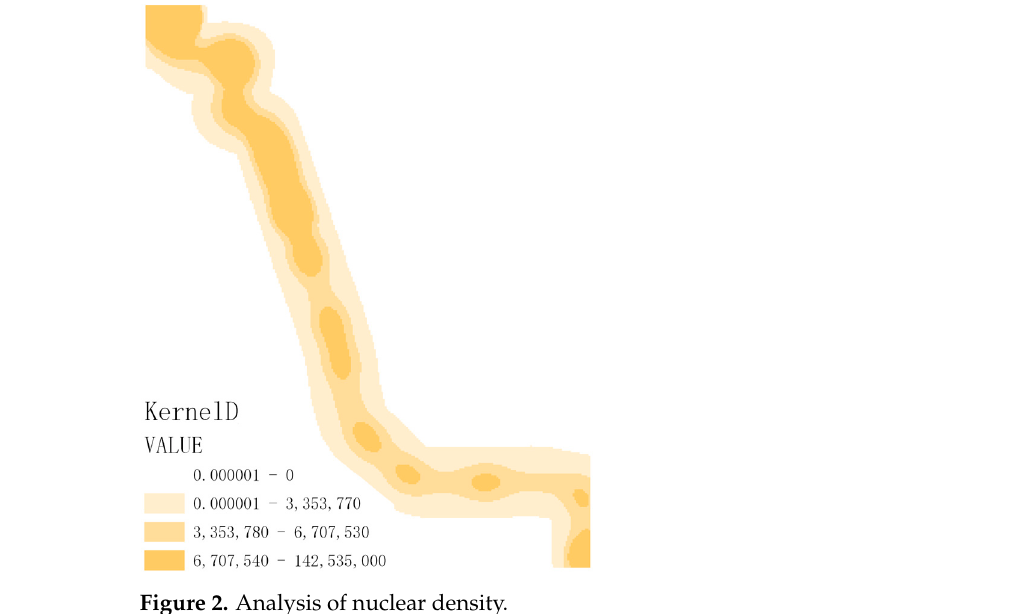
Figure 2. Analysis of nuclear